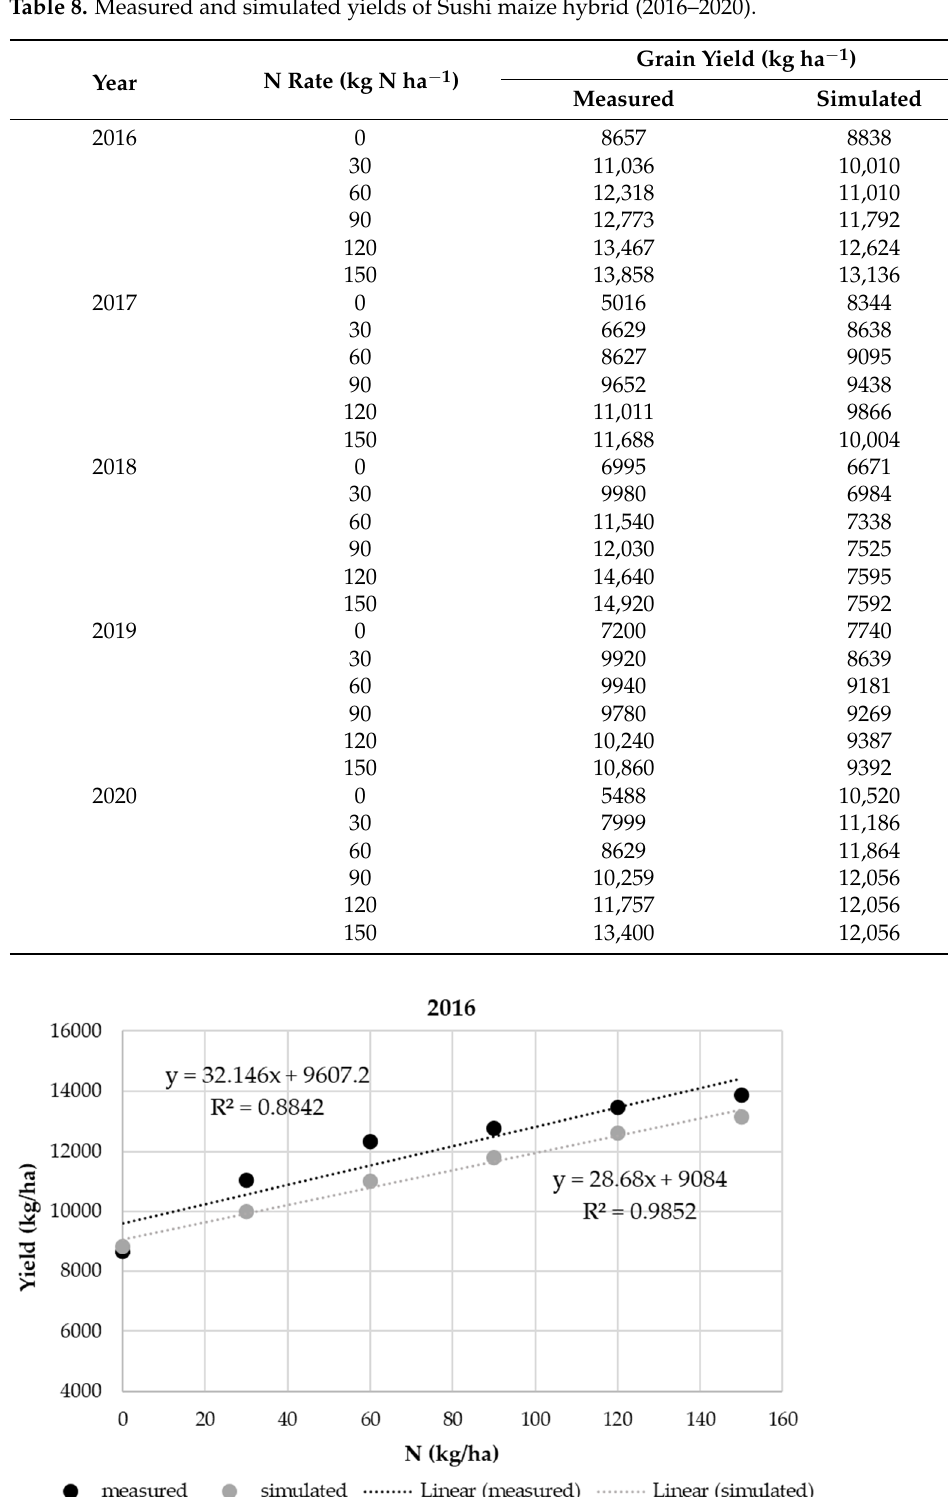
Figure 2. Comparisons between simulated and measured maize grain yield (2016). An increase in the nitrogen dose per unit increases the yield by 45.26 kg/ha for the measured data, while it was 11.74 kg/ha for the simulated data. Up to the N60 dose, the model estimated yields at the top and then at the bottom (Figure 3) In 2018, the simulated results (R 2 = 0.87) followed the increase in yield in parallel with the increase in the fertilizer dose. However, the values lagged far behind the measured results (R 2 = 0.94). An increase in the nitrogen dose per unit increases the yield by 51.51 kg/ha for the measured data, while it was 6.30 kg/ha for the simulated data (Figure 4) Figure 3. Comparisons between simulated and measured maize grain yield (2017).